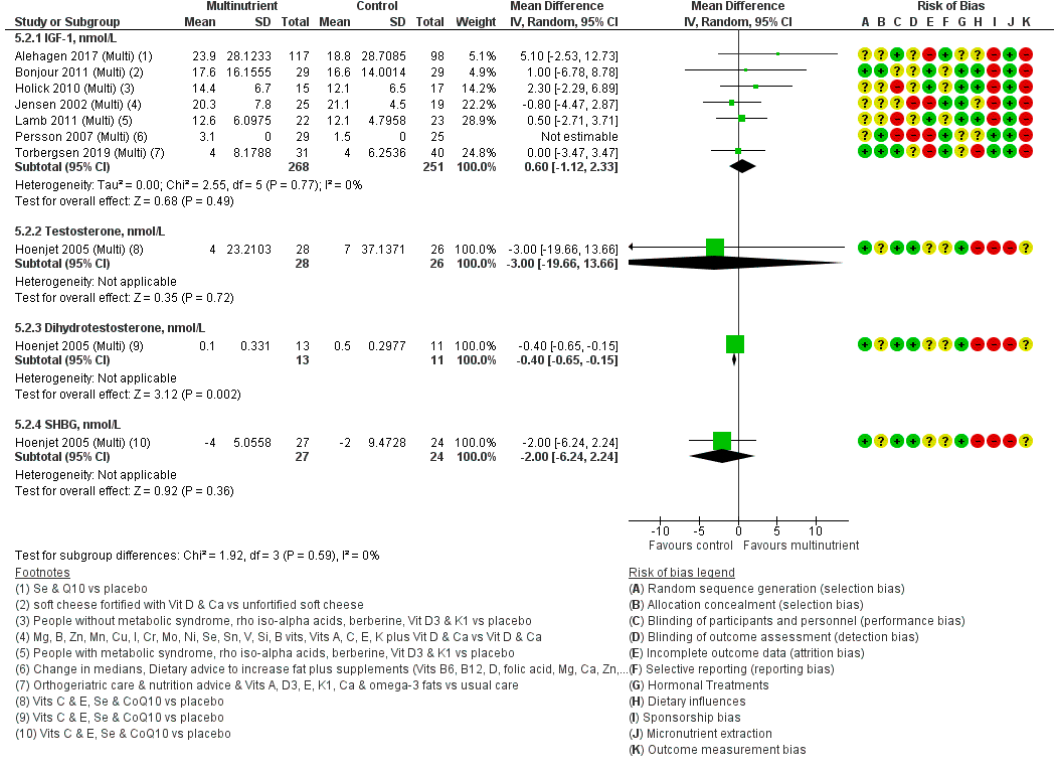
Figure 6. Forest plot assessing the effects of multi-nutrient interventions on sex hormones and IGF-1 (nmol/L). Multi, multi-nutrient. Please refer to Supplementary Table S5, E to find detailed information on the studies and reference details.